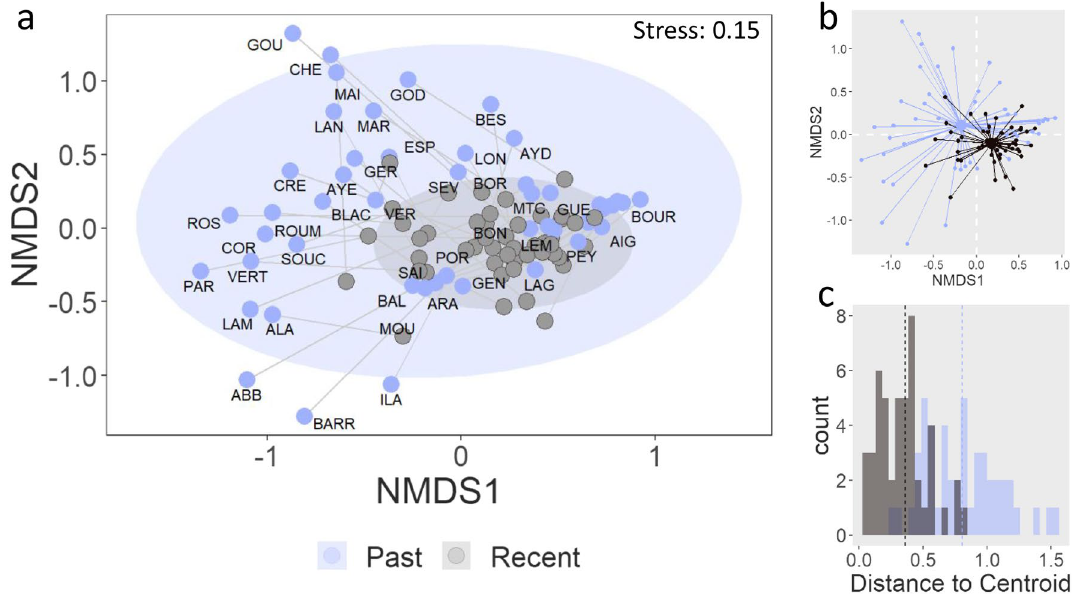
Figure 2. ( a ) NMDS of the community composition of the recent (grey dots) and past (purple dots) samples with the 95% confidence ellipses represented for each group. The past samples are labelled with their corresponding lake code (cf. Table S3), the grey lines connect recent and past samples from the same lake. Note: some labels are missing to avoid overlapping labels. ( b ) Spider plot showing the location of the geometric median of each group (i.e. past and recent) and illustrating the distance of the recent and past samples related to the geometric median of their respective group. ( c ) Distribution of the distances between samples and group geometric median (i.e. centroid) for recent and past samples, the geometric median of each group is indicated by the dotted